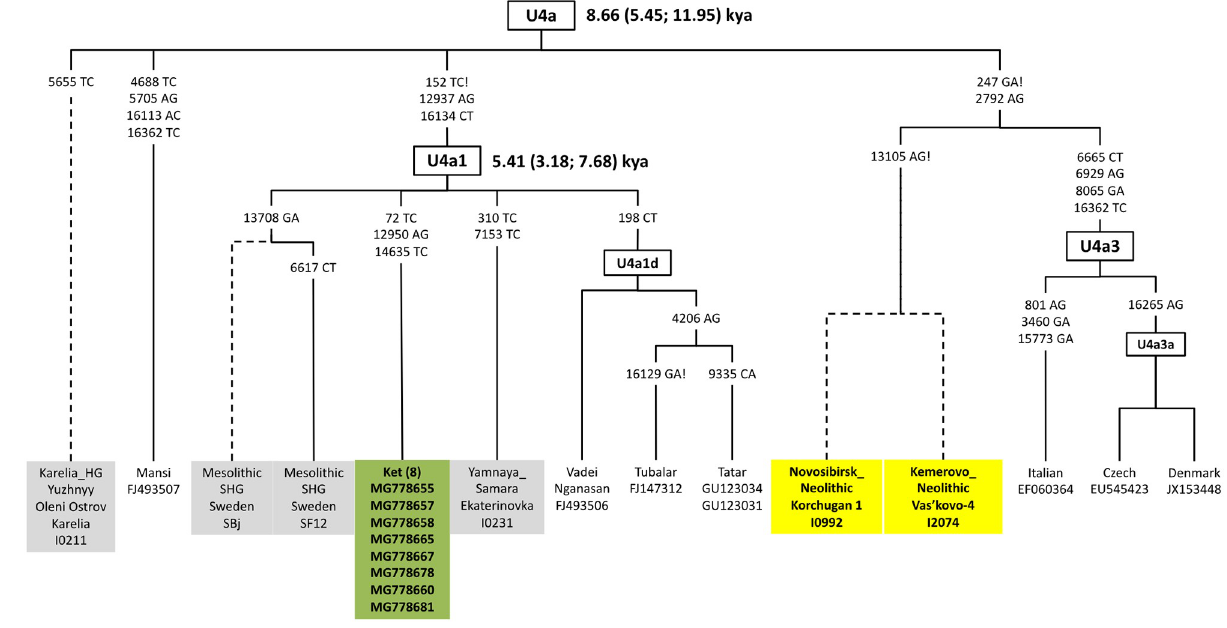
Fig 3. A phylogeny of distinct U4a branches and subbranches.